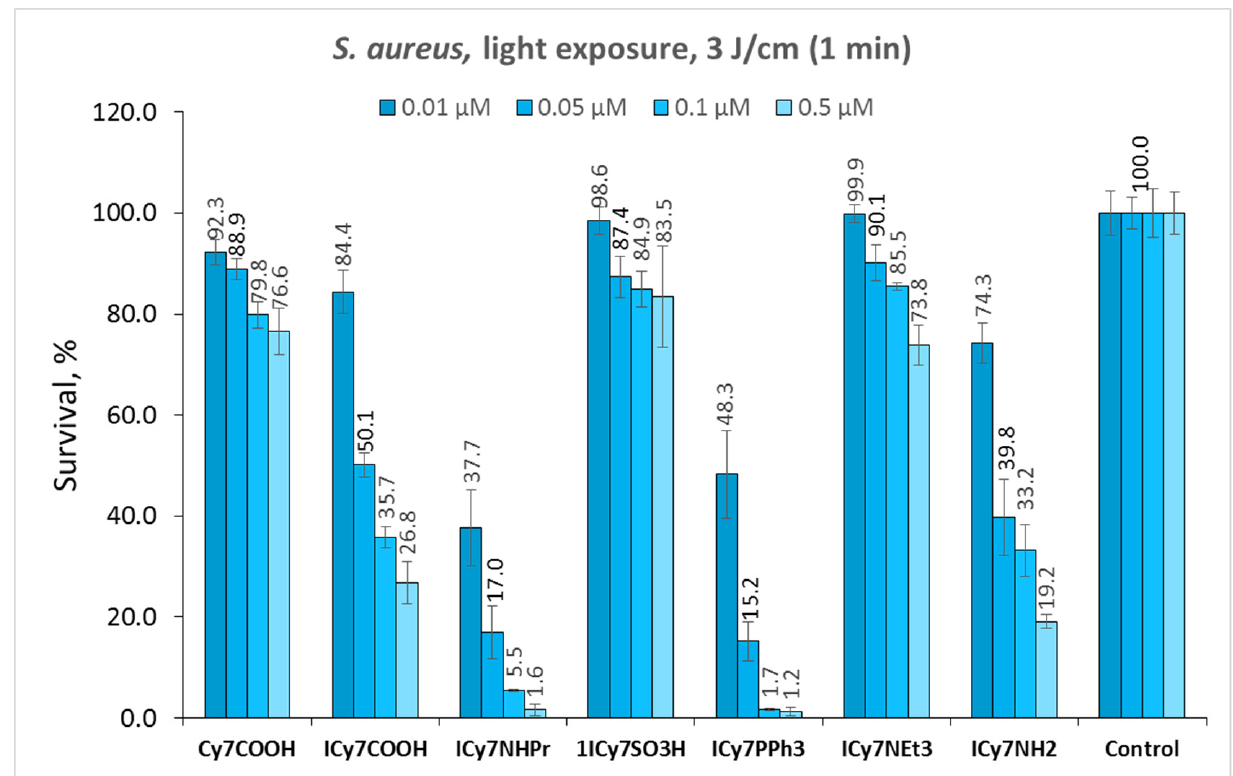
Figure 3. Survival of S. aureus in saline containing 0.7% DMSO, when exposed to 3 J/cm 2 light dose (56 mW/cm 2 , 1 min) vs. the dye concentrations. Light-irradiated cells without dyes were used as a control.